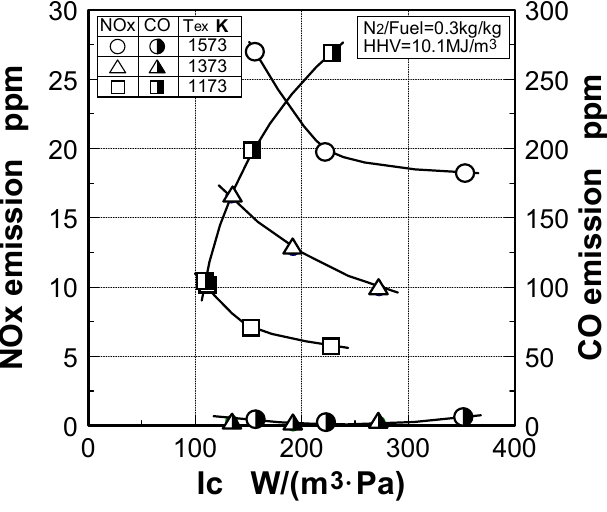
Figure 72. Effect of combustion intensity on combustion emission characteristics.